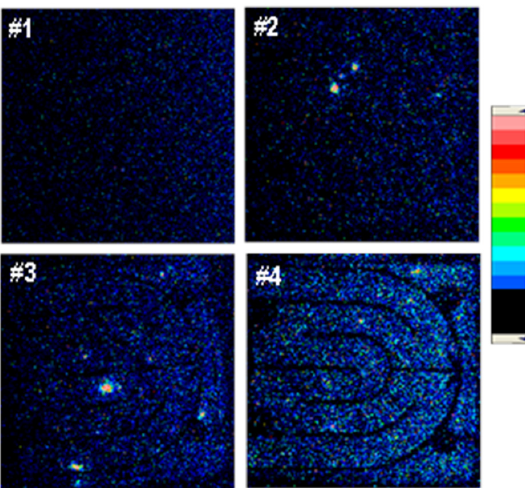
Figure 3. Light-emission patterns of NUV LEDs at 1 μ A (~2.4 V) measured by a Hamamatsu PHEMOS-1000 system. Appl. Sci. 2019 , 9 , x FOR PEER REVIEW